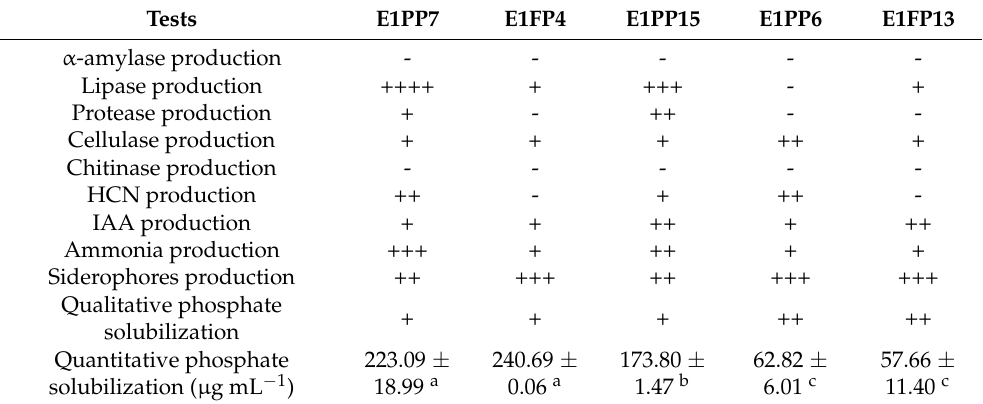
Table 2. Evaluation of plant-growth-promoting and antifungal properties of selected Pseudomonas .